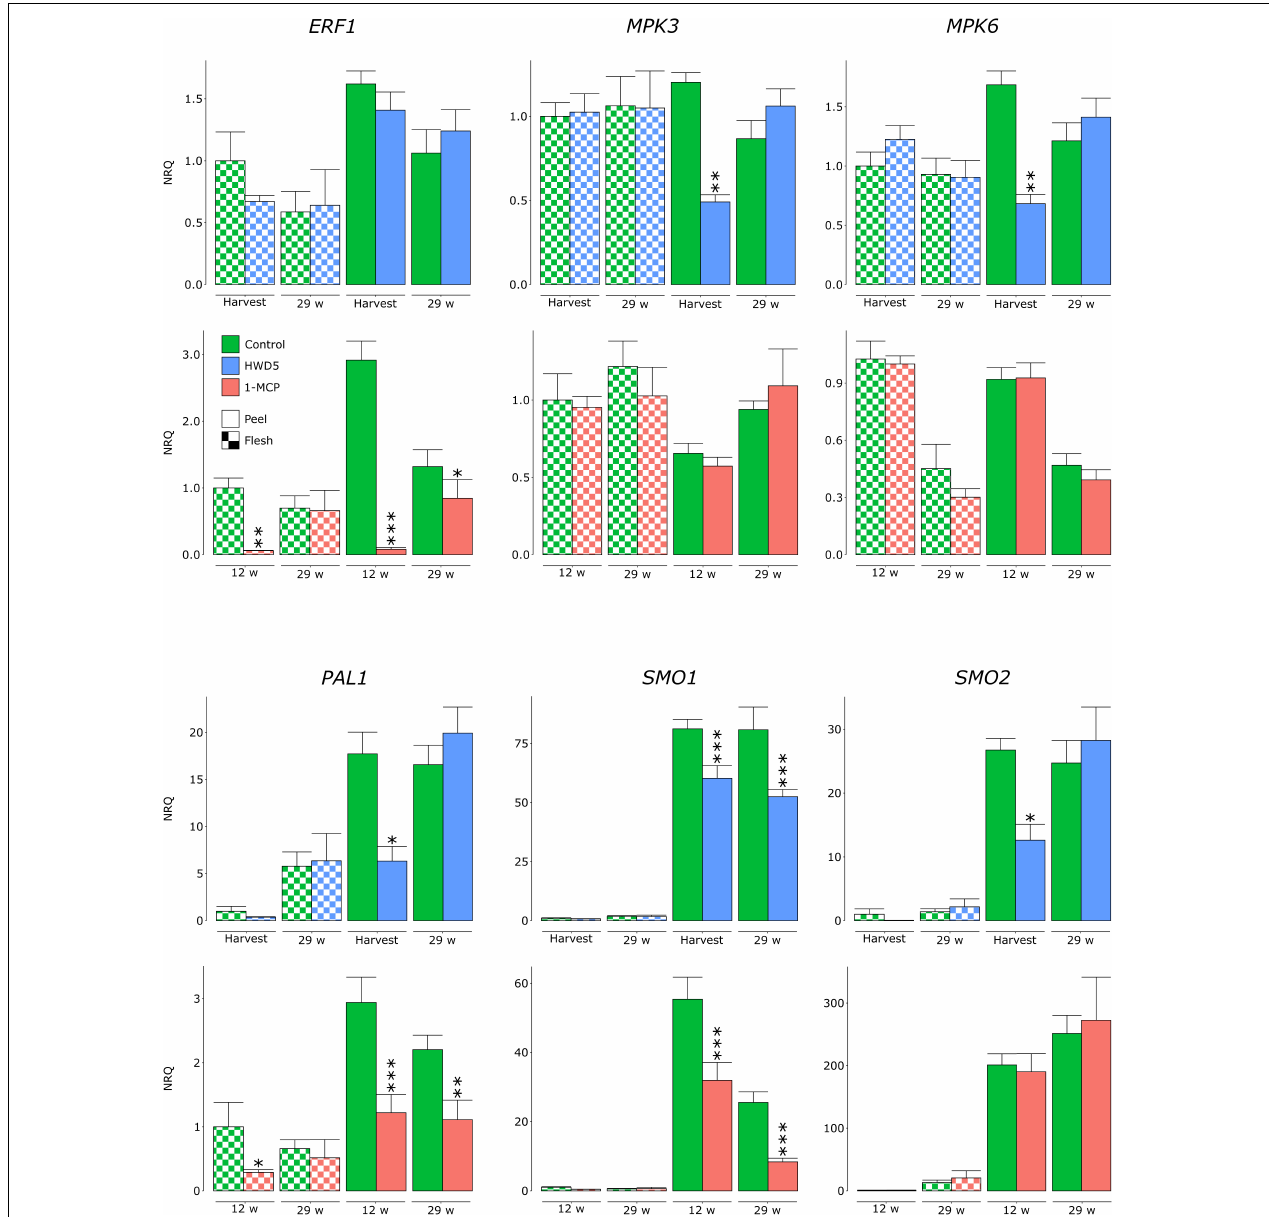
FIGURE 7 | Normalized relative quantities of genes analyzed in flesh and peel samples of “Jonagored” apples belonging to control, HWD5 or 1-MCP treatment. Samples were analyzed at harvest and after 29 w of CA storage (control, HWD5) or after 12 and 29 w of CA storage (control, 1-MCP). Error bars denote the standard errors of at least 6 biological replicates. Statistically significant differences with the control are denoted with asterisks: ∗ p < 0.05 ∗∗ p < 0.01 ∗∗∗ p <